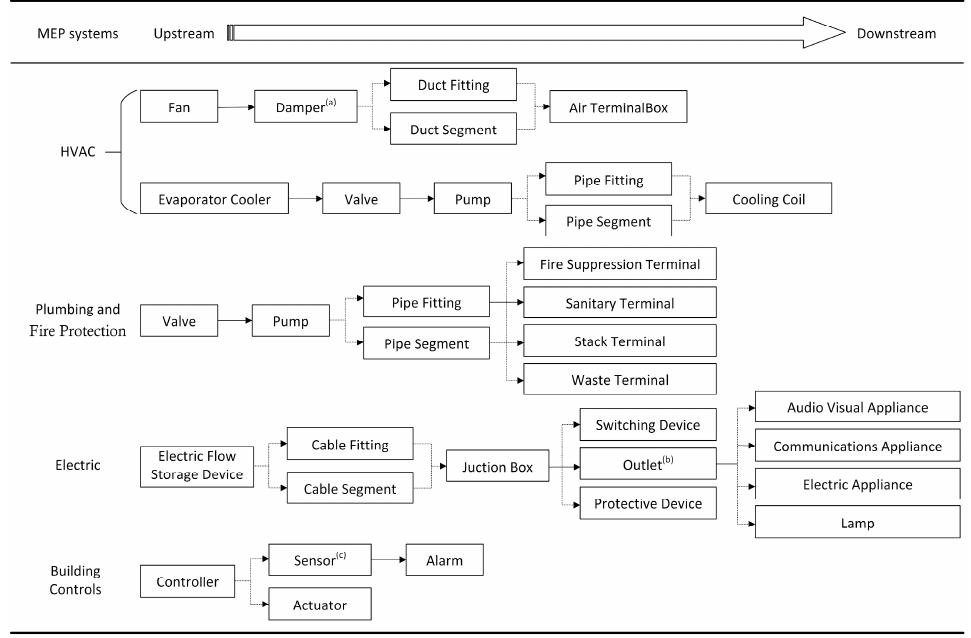
Figure 7. Typical logic relationships of Element types within several MEP subsystems.